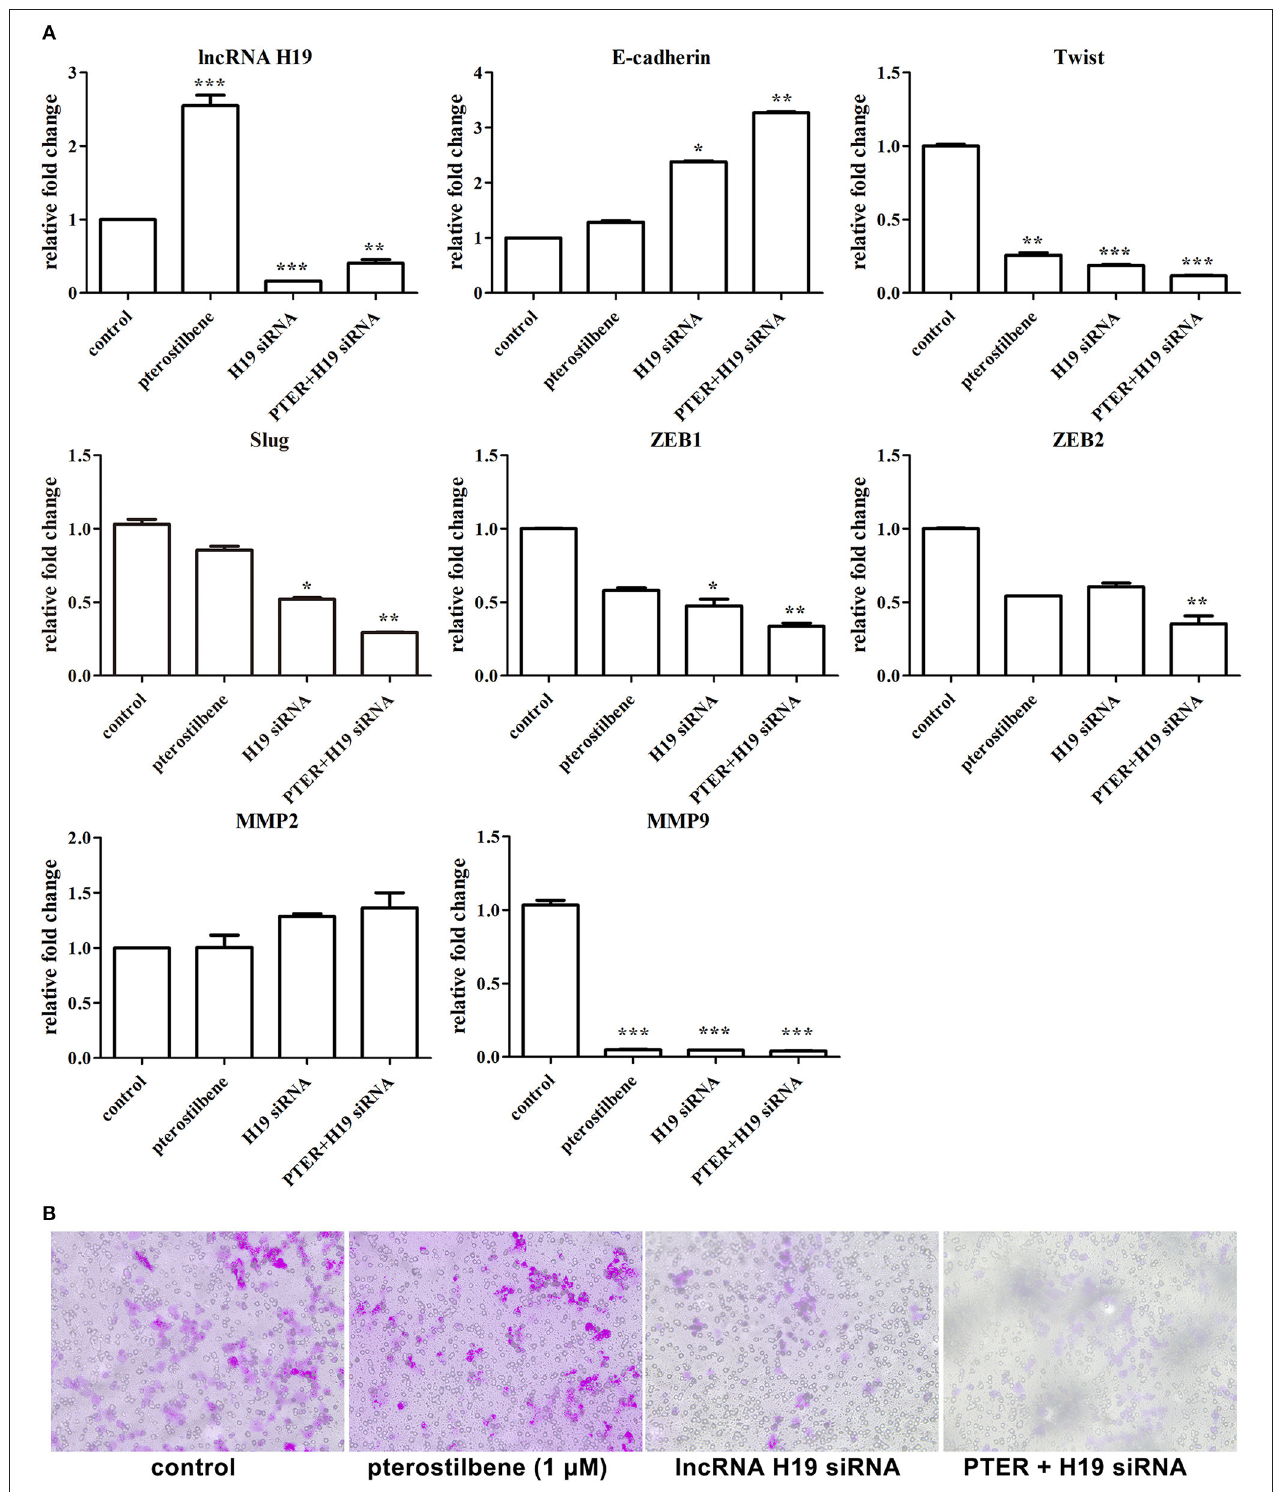
FIGURE 12 | lncRNA H19 knockdown further impaired migration and EMT in cancer cells. (A) Gene expression in cells after pterostilbene (PTER) treatment and/or lncRNA H19 knockdown. Reported values are mean ± SEM. * p < 0.05, ** p < 0.01 and *** p < 0.001, indicate significant differences compared with the control group. (B) Cell migration examined by Transwell